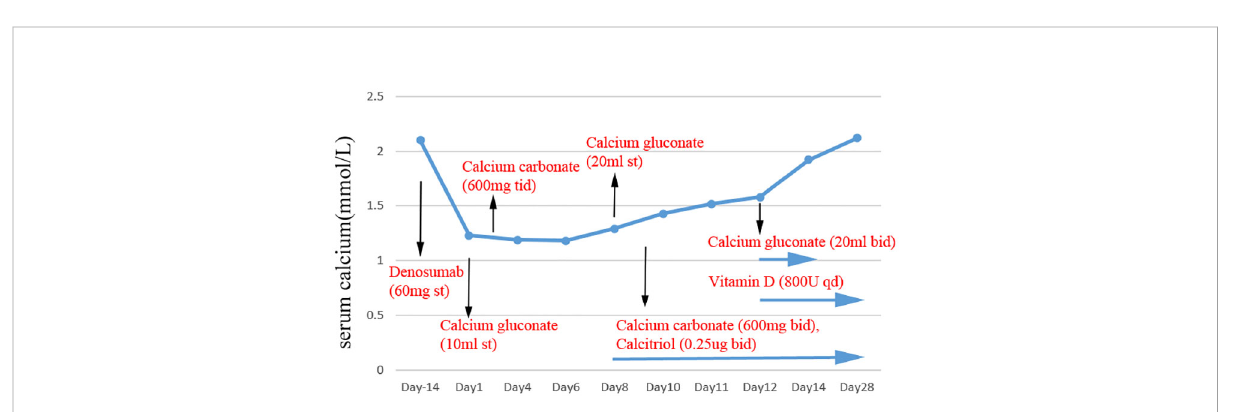
FIGURE 2 The level of serum calcium after denosumab administration. Black arrows mark the time of denosumab, calcium gluconate, calcium carbonate, vitamin D and calcitriol supplementation.